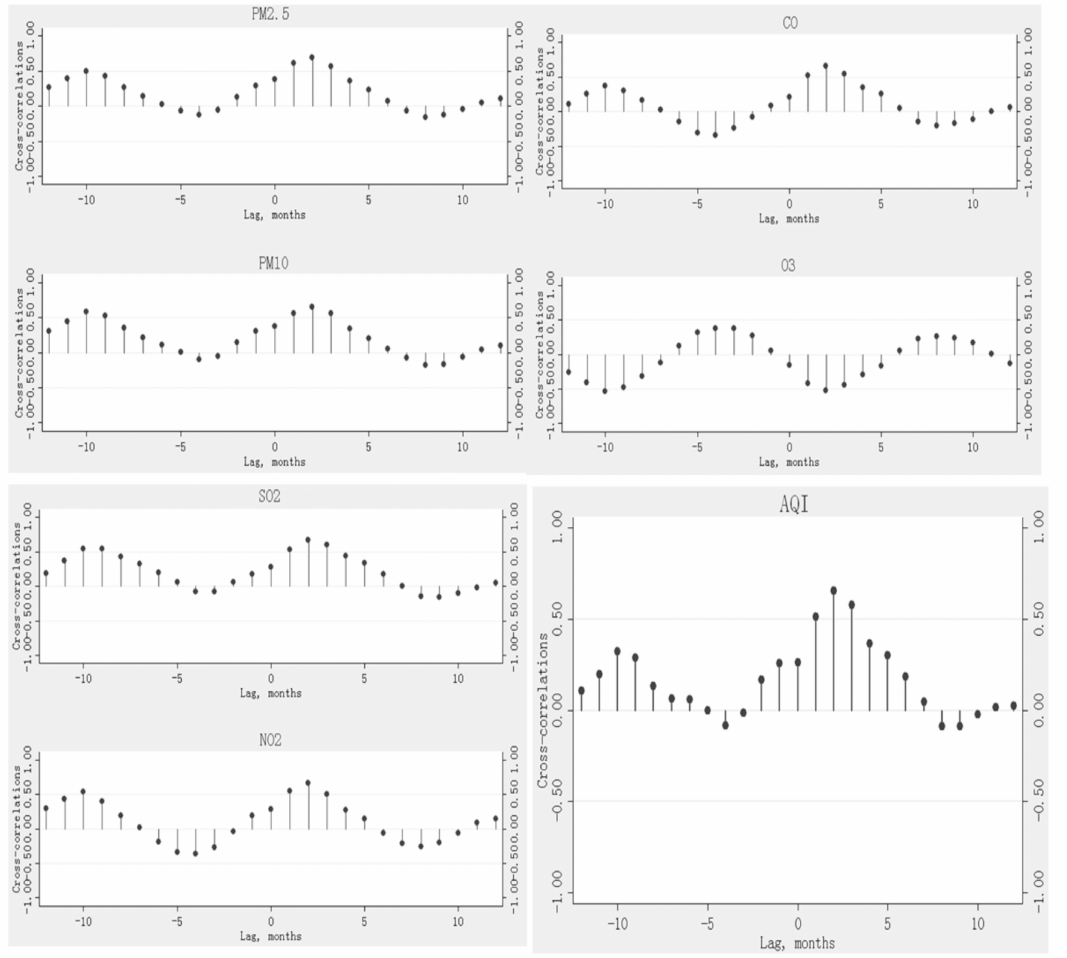
Figure 1. Cross-correlograms between 6-month moving average concentrations of PM 2.5 , PM 10 , SO 2 , and AQI and the seasonality of tuberculosis, and cross-correlograms between 7-month moving average concentrations of NO 2 , CO, and O 3 and the seasonality of